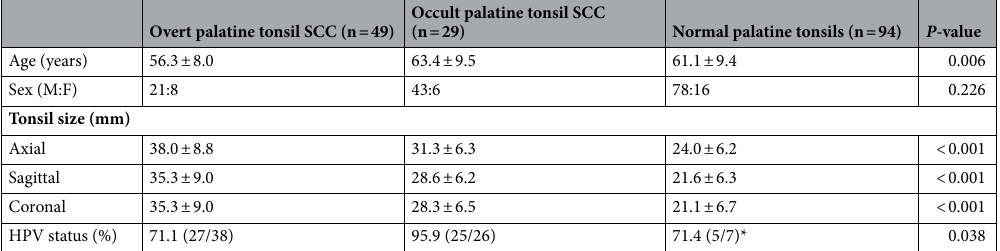
Table 1. Patient demographic characteristics. Numbers for age and tonsil size are the means ± standard deviation. HPV human papillomavirus; SCC squamous cell carcinoma. *The percentage indicates values for a limited number of patients with a carcinoma of an unknown primary site.